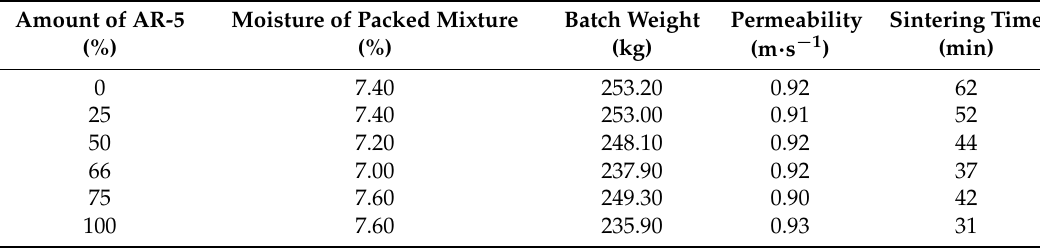
Table 6. Conditions of experimental sintering.